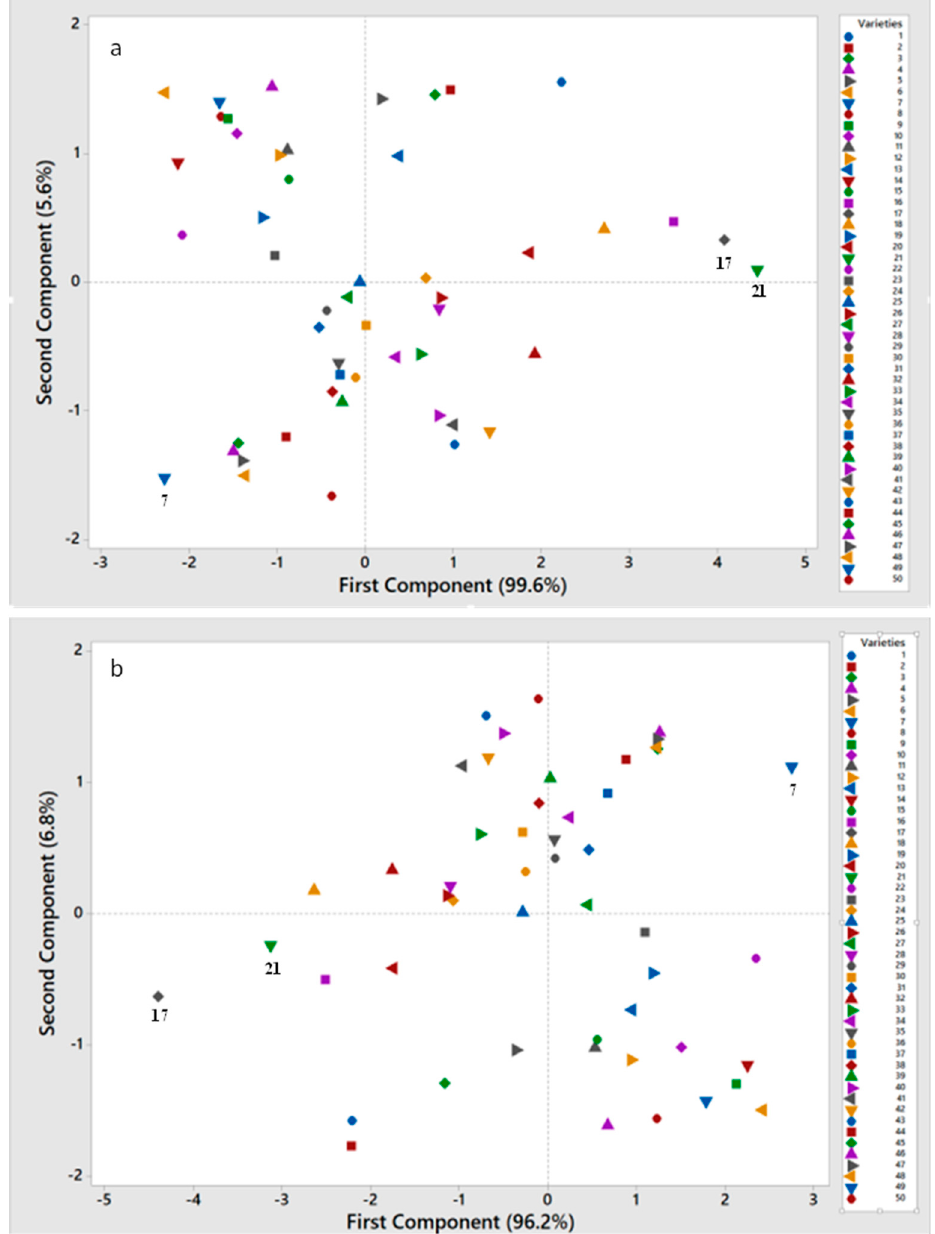
Figure 5. PCA analysis of the tested peach germplasms. Note: ( a ) PCA analysis of the response values produced by the three main sensors [W5S (sensor for nitrogen oxides), W1S (sensor for methane compounds), and W1W (sensor for hydrogen sulfide)]. ( b ) PCA analysis of the response values produced by the three aromatic sensors [W2W (sensor for aromatic components and organic sulfide), W3S (sensor for ammonia), and W1C (sensor for aromatic benzene)]. 7: ‘Yuntaishanshantao’; 17: ‘Hongfenjiaren’; and 21: ‘Hua 3’.